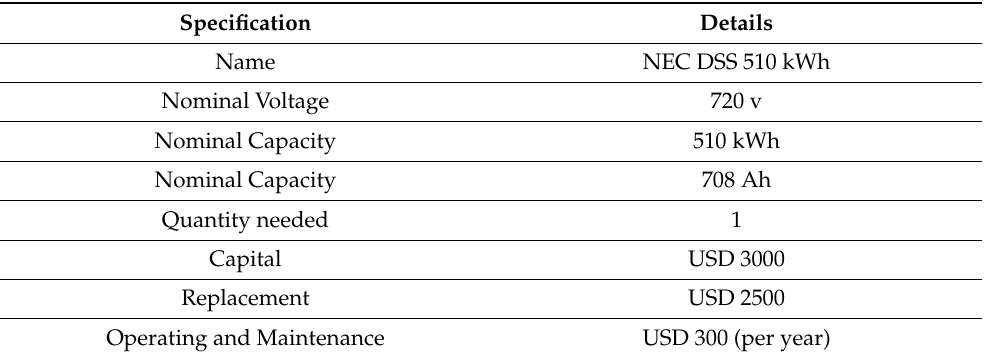
Table 4. Battery storage specifications.